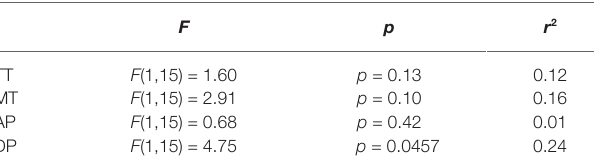
TABLE 2 | Statistical correlations between Visual Analogical Scale estimates of thirst at the end of the experiment and main kinematic parameters.